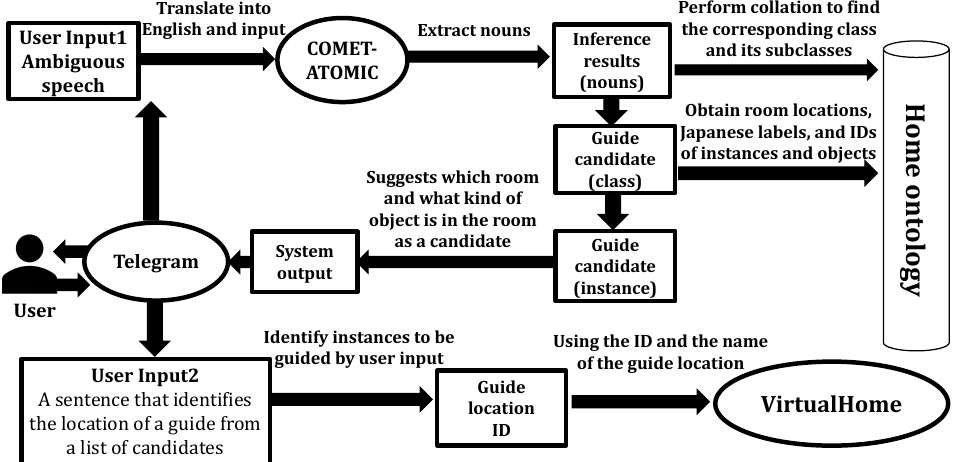
Figure 13. The flow of location guidance from user’s speech based